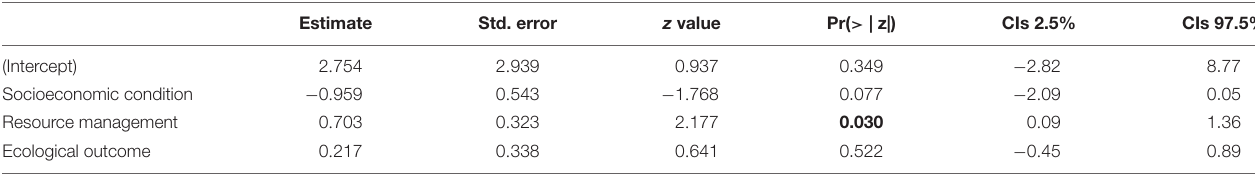
TABLE 7 | Results of generalized linear model shows factors that influence fisher’s (engaged in hilsa fisheries) decision on whether fishing ban good or bad based on fishers’ survey.